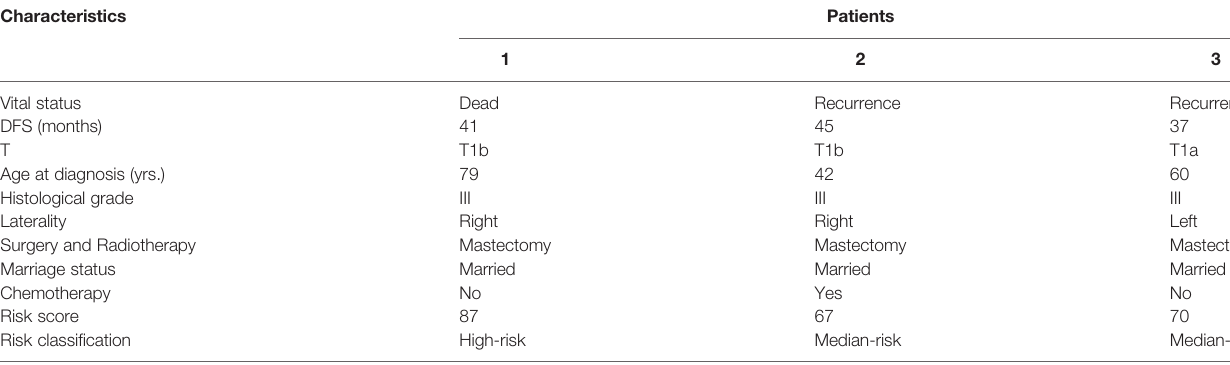
TABLE 5 | Clinical characteristics of patients with death and recurrence during follow-up.